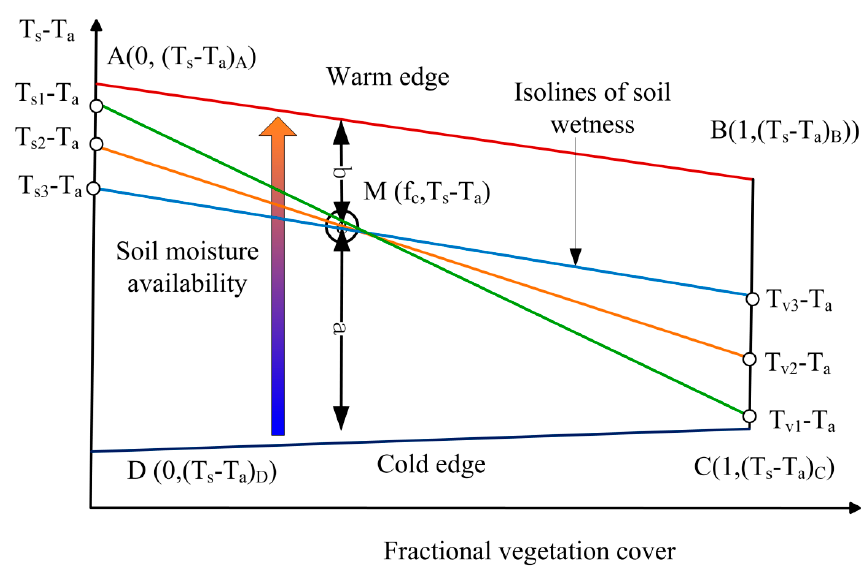
Figure 10. Illustration of the temperature decomposition methods adopted in the three TSEB models. T s1 , T s2 , and T s3 denote the soil surface temperatures derived from TSEB-PM, TSEB-PT, and TSEB- T C - T S , respectively, and T v1 , T v2 , and T v3 denote the vegetation canopy temperatures derived from the same three models.